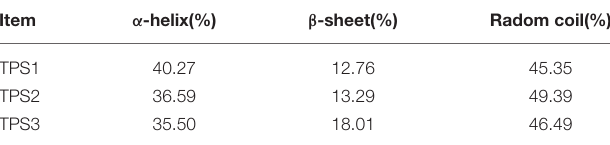
TABLE 3 | The prediction of the secondary structure of TPS in brown planthopper. Item α -helix(%) β -sheet(%) Radom coil(%) TPS1